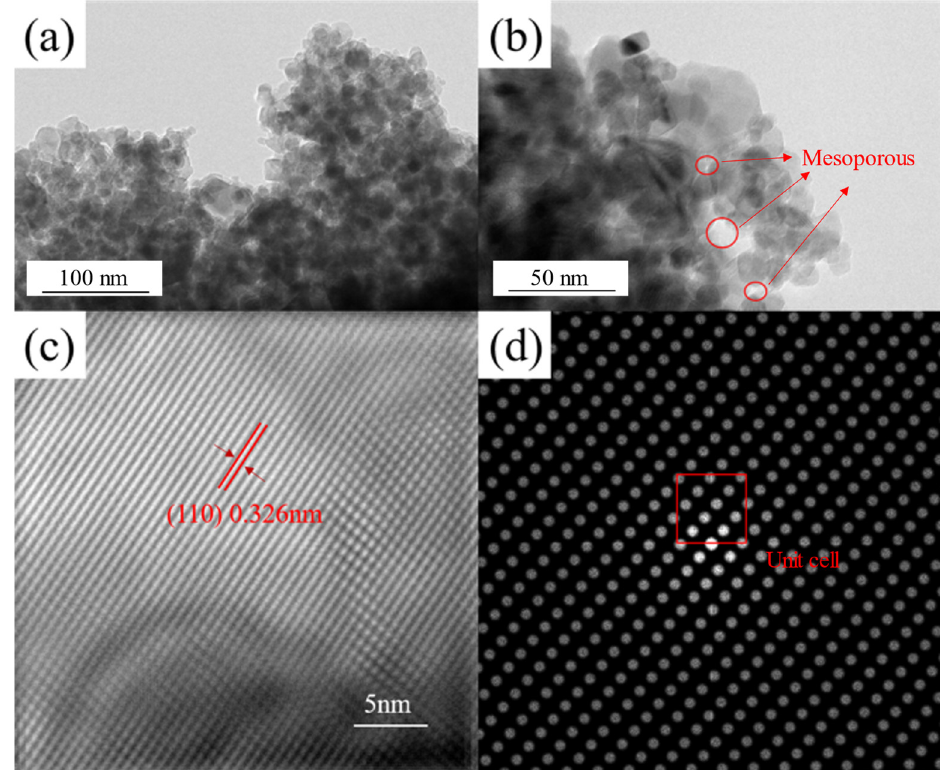
Figure 4. ( a , b )TEM images of the TiO 2 -P25 mesoporous composite. ( c ) High-resolution TEM image of the TiO 2 -P25. ( d ) The selected area diffraction pattern from the ( c ).